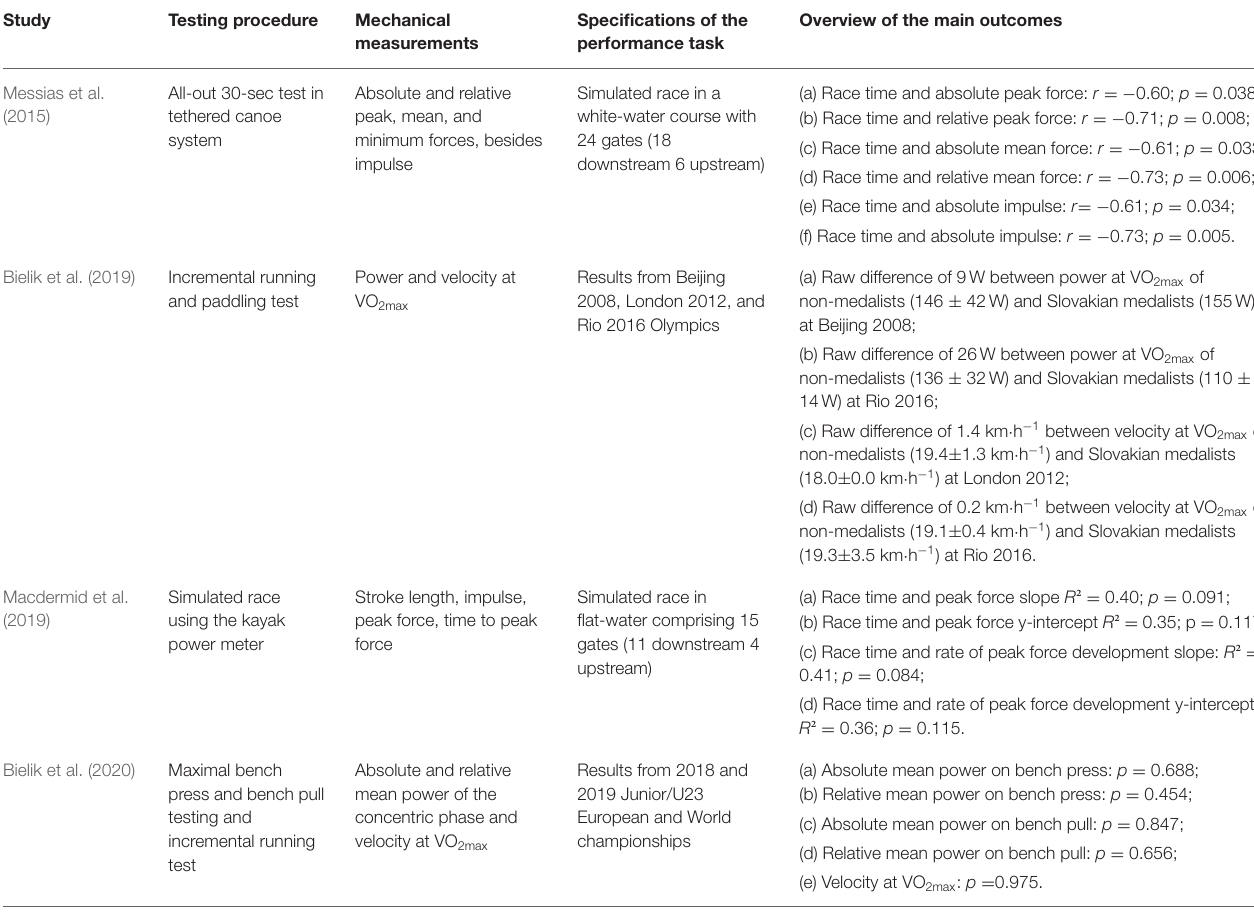
TABLE 2 | Methodological aspects and main results from studies that associated the slalom performance with mechanical parameters or compared mechanical data between athletes with distinct canoe slalom performances.